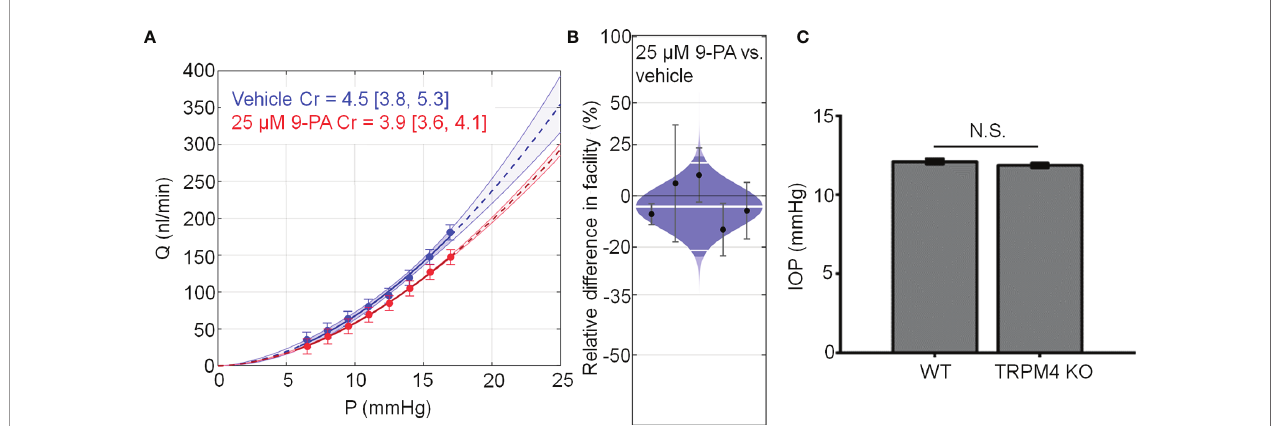
FIGURE 8 | TRPM4 does not regulate trabecular out fl ow and steady-state intraocular pressure. (A) Representative fl ow-pressure ( Q – P ) plot for contralateral eyes perfused with 25 µM 9-PA versus vehicle. Curves show the optimal fi t from Equation 1, with 95% con fi dence bounds and error bars show 95% con fi dence intervals. (B) Relative difference in out fl ow facility between contralateral eyes perfused with 25 µM 9-PA versus vehicle. The relative difference in facility is de fi ned as the ratio of C r in the experimental eye perfused with 9-PA relative to vehicle-perfused contralateral eye minus unity, expressed as a percentage. Each data point represents the relative difference in facility for an individual mouse. Error bars are 95% con fi dence intervals. Shaded regions represent the best estimate of the sample distributions, with the central white line representing the geometric mean. Dark central bands represent the 95% CI on the mean, and the outer white lines represent the limits encompassing